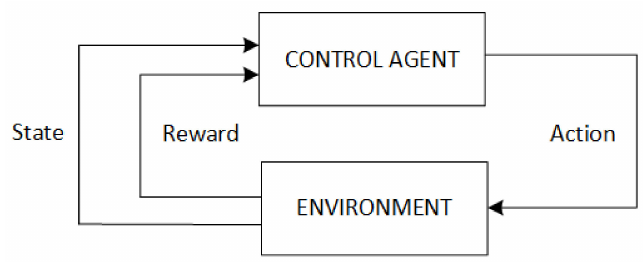
Figure 3. Reinforcement Learning interaction process